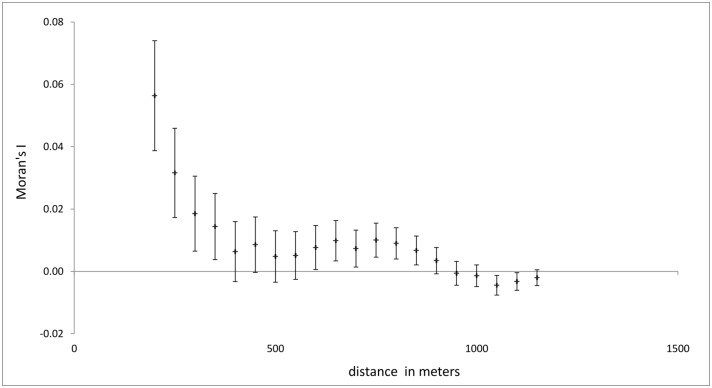
Plot showing the correlation between household prevalence rates as a function of distance (Moran’s I statistic of spatial autocorrelation).Spatial autocorrelation was calculated by incremental distance intervals of 50 meters starting at 200 meters.